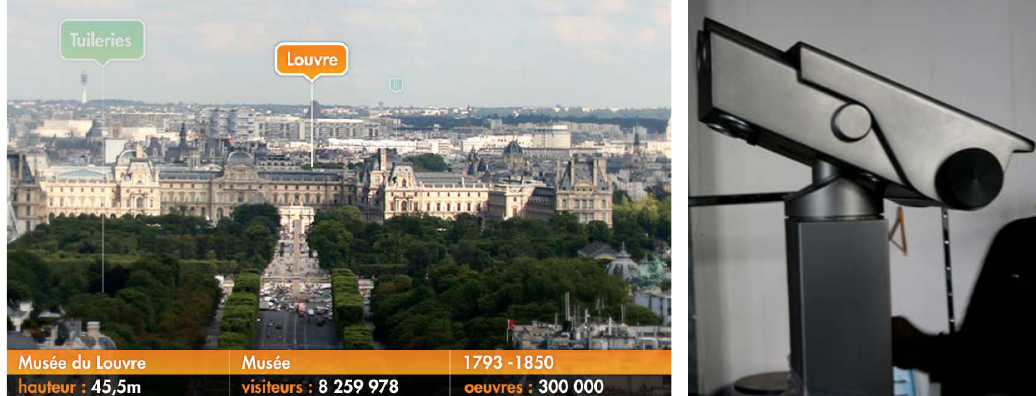
Fig. 1. Augmented Reality Telescope for Heritage Valorization. (left) “ Paris, Champs Elysée ” avenue panoramic view with a focus on “ Palais du Louvre ”. (right) Our Telscopoe.